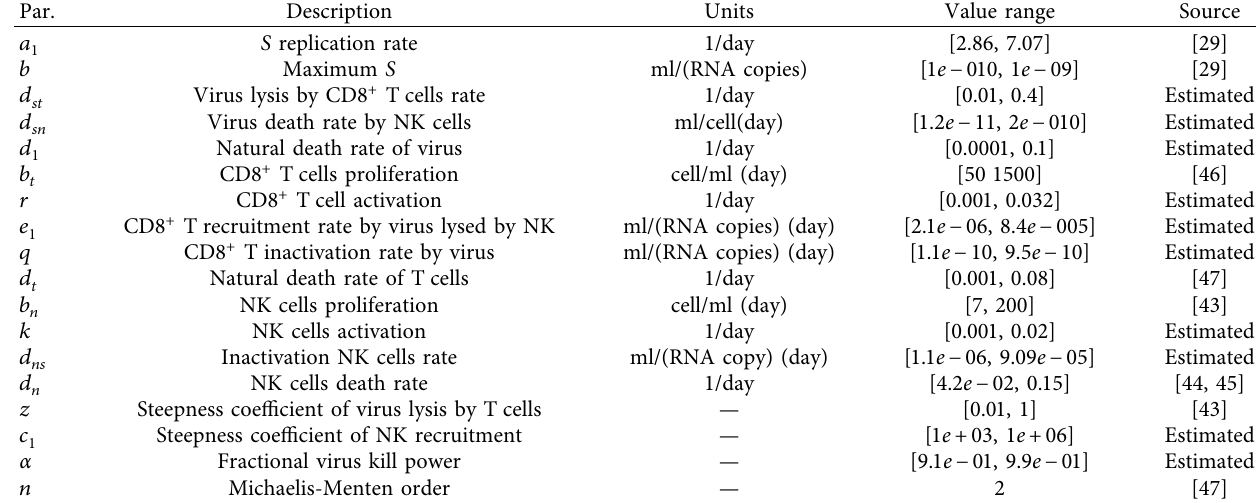
Table 1: Information of the parameters.